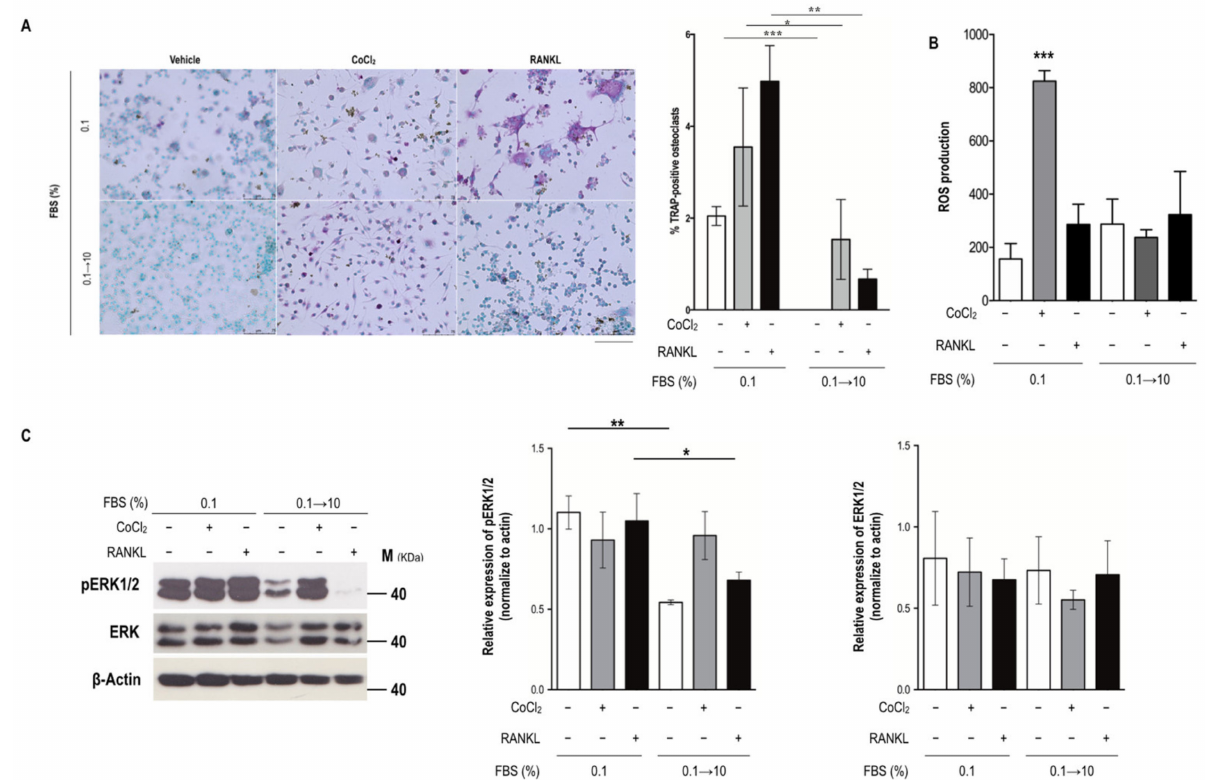
Figure 3. Number of TRAP-positive osteoclasts and ROS production level after serum reperfusion. Purple indicates TRAP expression, and cyan indicates nuclei. ( A – C ) After the application of 0.1% FBS or the ischemic condition treatment for 3 days, the medium was replaced with a medium containing 10% FBS for 4 days. All data are presented as mean ± SD ( n = 3). ( A ) Osteoclast formation. Bar height indicates the number of TRAP-positive osteoclasts ( ≥ 3 nuclei) counted in five randomly selected areas in each well, normalized to the total cell number. ( B ) ROS production. Bar height indicates the fluorescence intensity after incubation with 2 (cid:48) ,7 (cid:48) -dichlorodihydrofluorescein diacetate (DCFDA). ( C ) Expression of pERK. Bar height indicates the identity of pERK, normalized to that of total ERK protein. Asterisks at the tops of bars indicate significant differences between two groups (* p < 0.05, ** p < 0.01, and *** p < 0.001). Abbreviations: FBS, fetal bovine serum; RANKL, receptor activator of nuclear factor kappa-B ligand; ROS, reactive oxygen species; TRAP, tartrate-resistant acid phosphatase. Scale bar: 50 µ